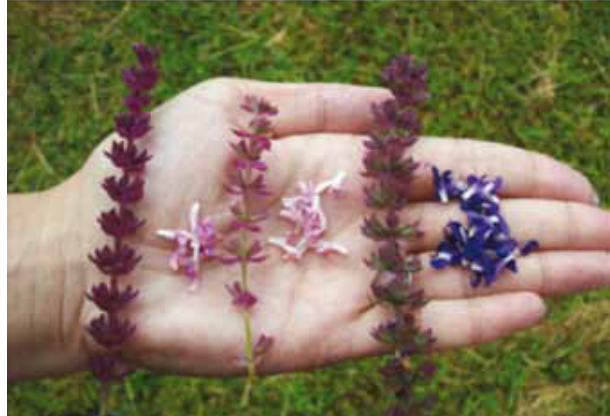
Figure 4: New colour versions of the Salvia nemorosa